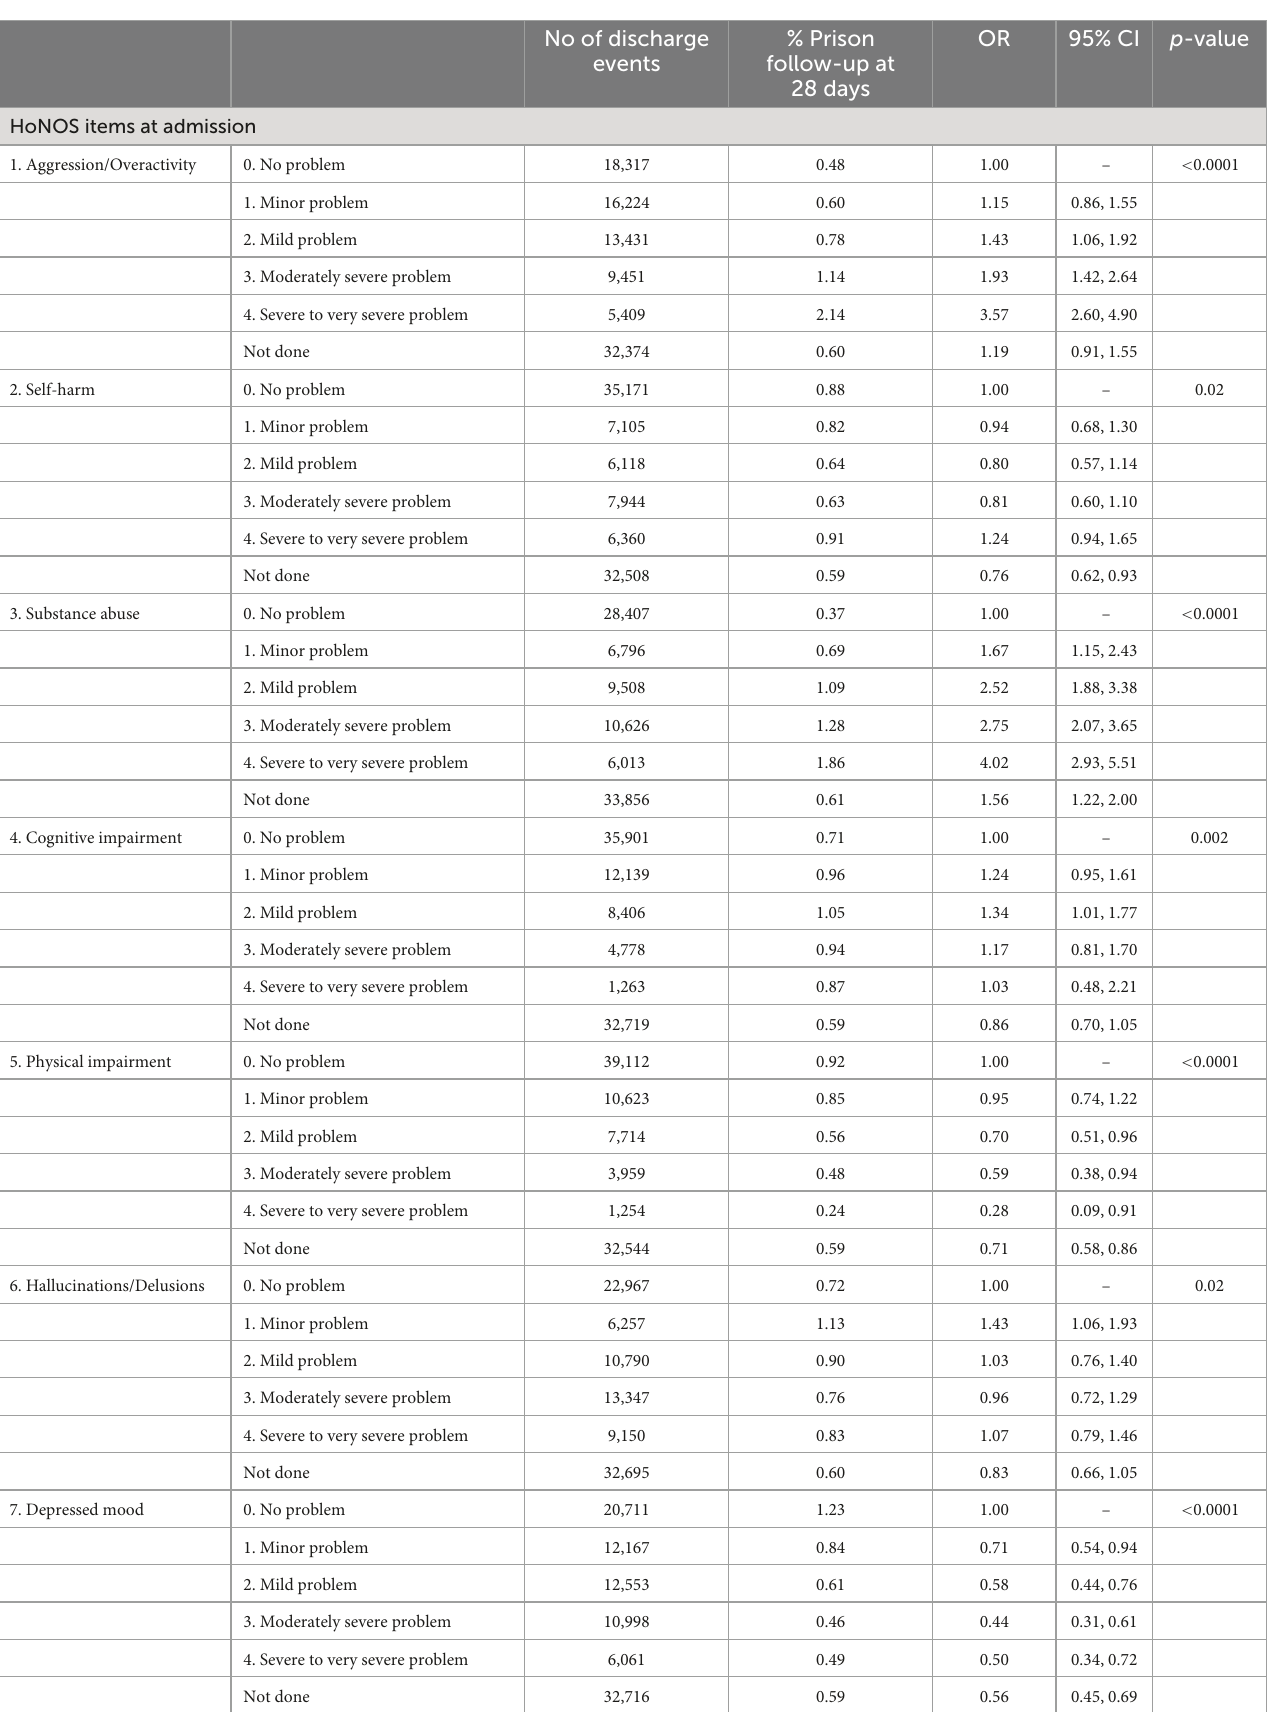
TABLE 3 Bivariate associations with custodial remand within 28 days: Health of the Nation Outcome Scale (HoNOS) admission and discharge item scores.